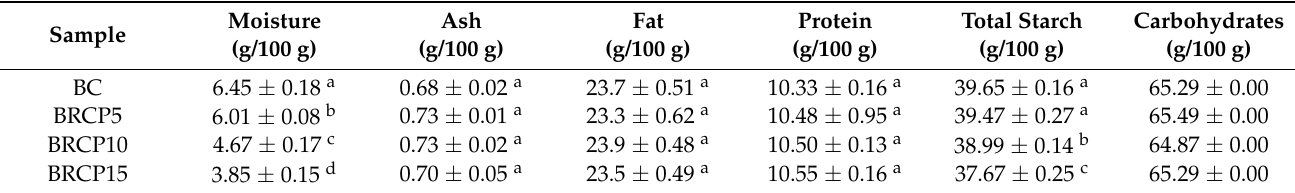
Table 3. Proximal composition of